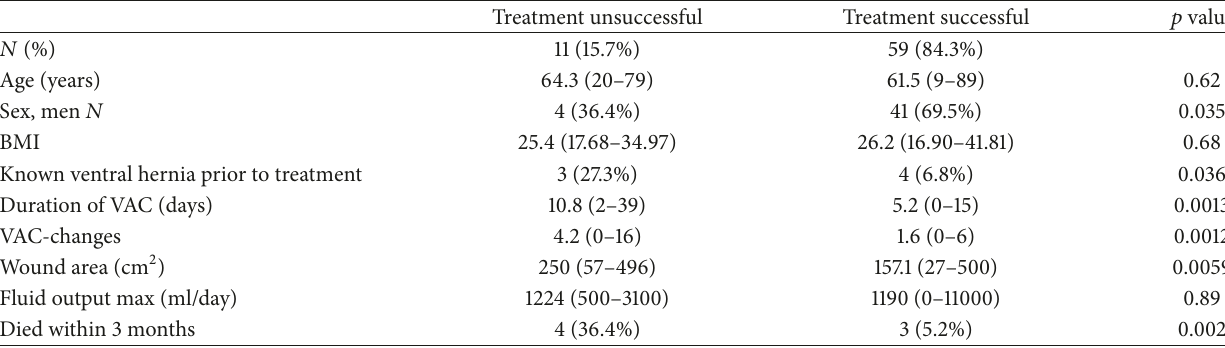
Table2: Clinicalbackgrounddataandprocedurerelateddatainthosewithanunsuccessfulandsuccessfultreatment. Unlessotherwisestated, the results are given as median (range) or number 𝑁 (%).